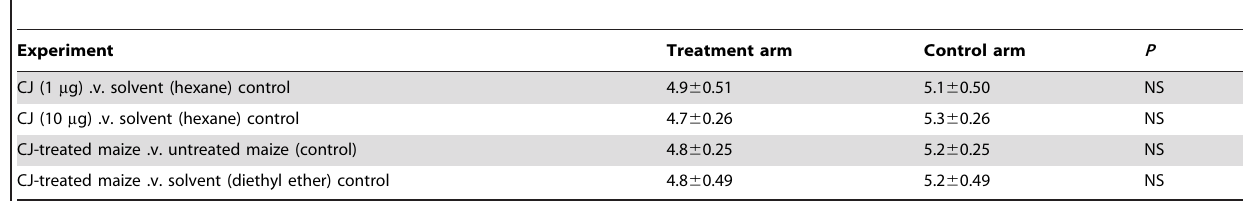
Table 1. Behavioural response (mean number 6 SE) of Cicadulina storeyi leafhoppers to cis -jasmone (CJ), and VOCs collected from CJ-treated and untreated maize ( Zea mays ) seedlings in a Y-tube olfactometer.